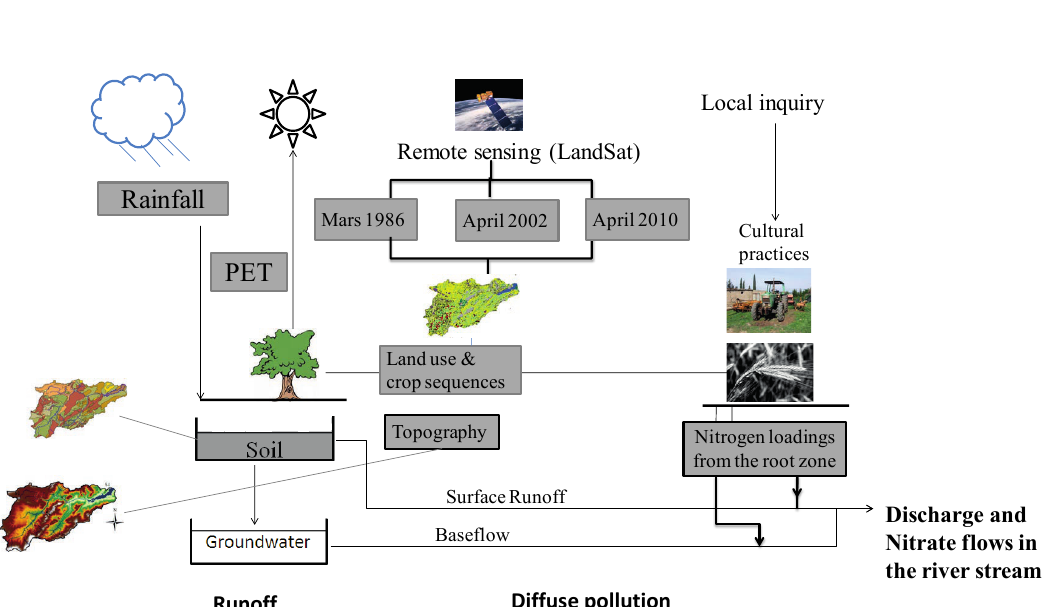
Fig. 1 Study area location.